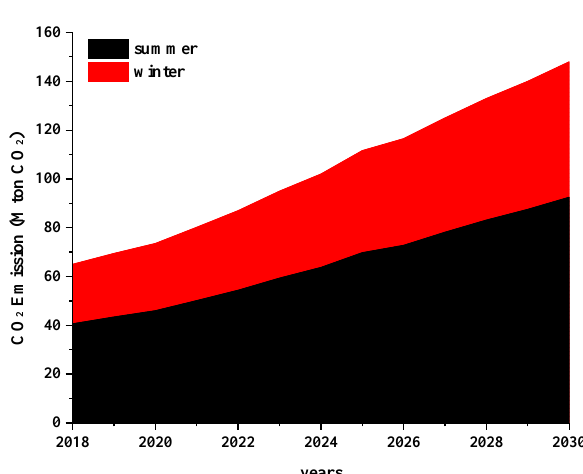
Figure 1. Pakistan 2018 energy mix.